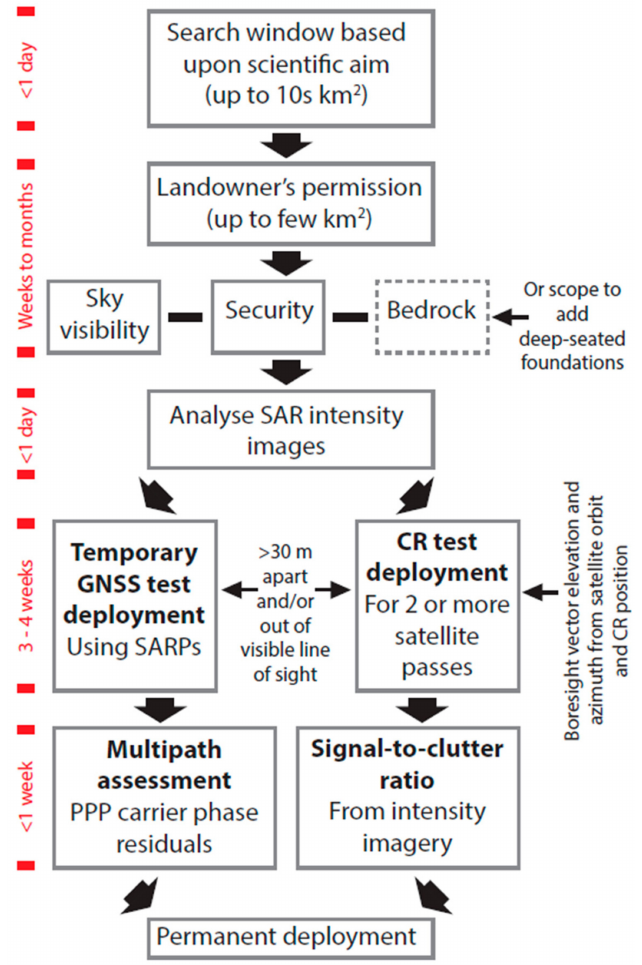
Figure 8. Flowchart of the recommended procedures for determining suitable sites for co-located cGNSS and corner reflectors (CRs) for integrated operational monitoring of vertical land motion (VLM). The time line provides a guide as to the time that should be allowed for each step, assuming that the user has access to, and experience with, the SAR and cGNSS data and processing tools. SARPs—standards and recommended